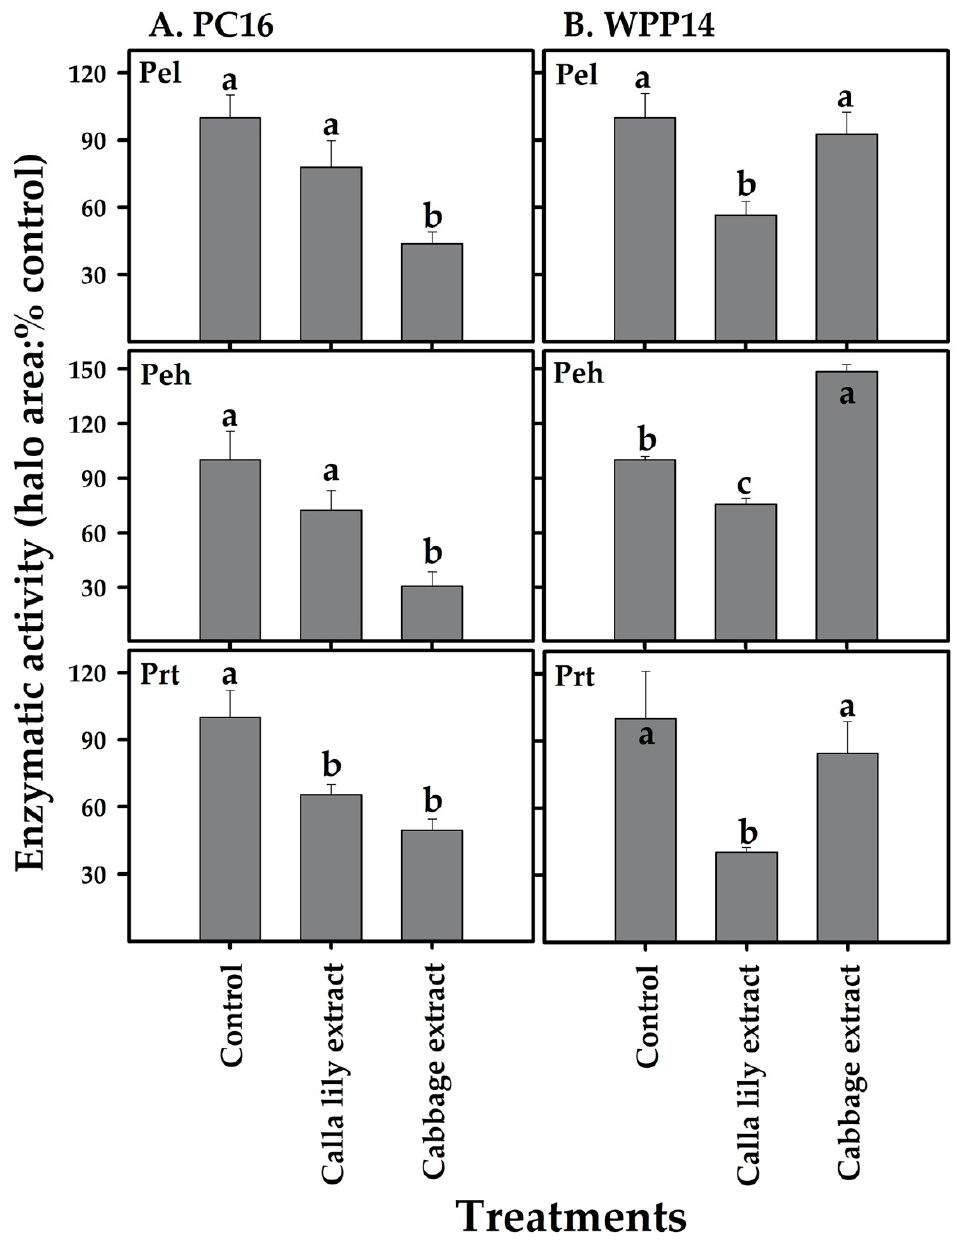
Figure 6. Effect of plant extracts (calla lily or cabbage) on the exoenzyme activity of Pectobacterium strains PC16 ( A ) and WPP14 ( B ). Enzymatic activity was measured 8 h after application of a non-lethal dose of plant extract to the microbial suspensions. Pel, Peh and Prt activities were determined based on the area of the haloes formed by substrate degradation. Results are expressed as the level of activity relative to that of the control (%). The experiments were repeated twice with eight replicates per treatment. Tukey–Kramer HSD test was used to test differences, bars labeled with different letter (a–c) are significantly different from each other ( p < 0.05; bar = mean ± SE; n = 16).